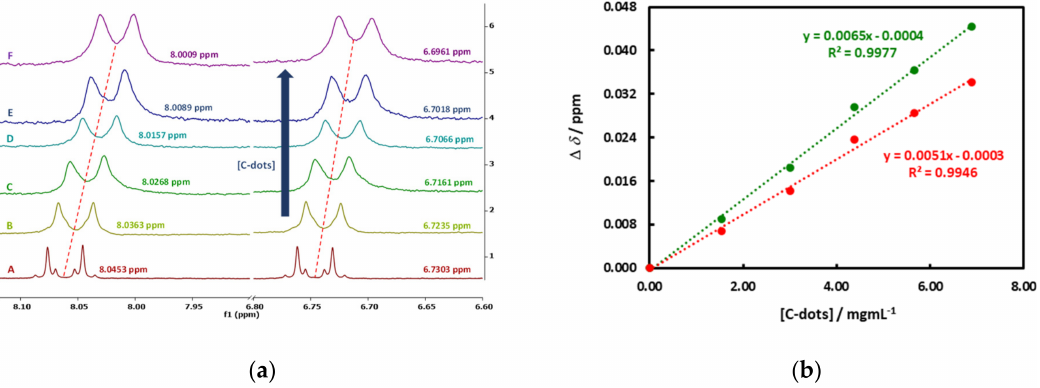
Figure 10. ( a ) Partial 1 H NMR spectra of titration of p -NA (5 mM in D 2 O; (A) by C-dots (increasing concentration (B)–(F) at 25 º C; ( b ) CIS of p -NA aryl protons with increasing C-dots